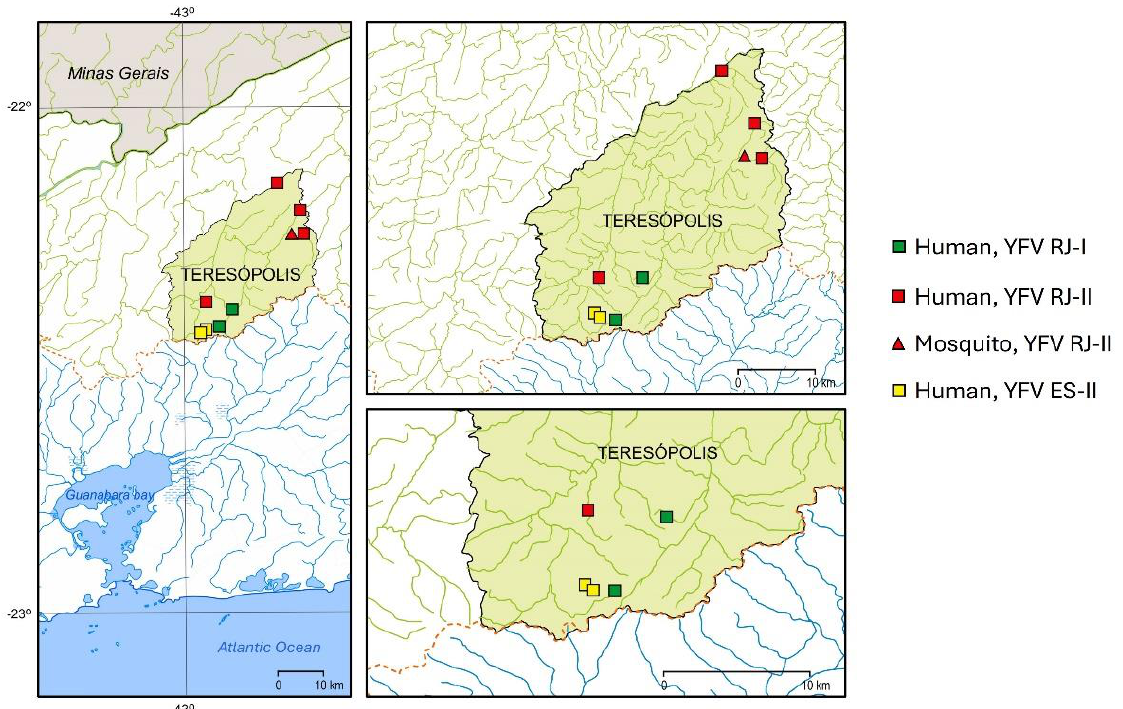
Figure 6. Spatial distribution of YFV samples from humans (square) and mosquitoes (triangle) from Teresópolis municipality. YFV samples clustered in clades YFV RJ I (green; coastal), YFV RJ-II (red; continental), and YFV ES II (yellow). The tributary rivers of the Macaé (coastal) and Paraíba do Sul (continental) conjugated river basins are outlined in green and blue, respectively.